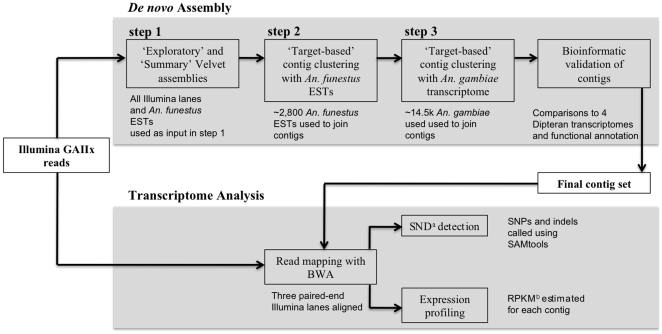

De novo transcriptome assembly and analysis workflow.Illumina reads were assembled in a series of ‘exploratory’ Velvet assemblies, the contig output of which was used in a ‘summary’ assembly. Following iterative assembly with Velvet, contigs were clustered and joined when possible, first using conspecific ESTs, then using the transcriptome of a closely related species. A final contig set was generated by selecting contigs based on bioinformatic support criteria. Illumina reads were then mapped to the final contig set and resulting alignments were used for expression profiling and polymorphism discovery. aSND refers to short nucleotide discrepancies including both single nucleotide polymorphisms and indels. bRPKM, or reads per kilobase per million mapped reads [40], was calculated for each contig and used to represent expression level.